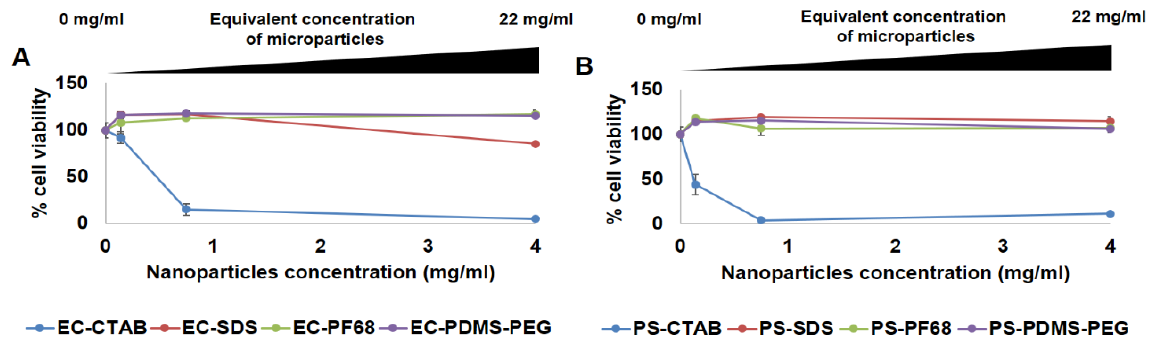
Figure 5. ( A ) % Cell viability in presence of ethyl cellulose NPs. ( B ) % Cell viability in presence of polystyrene NPs.